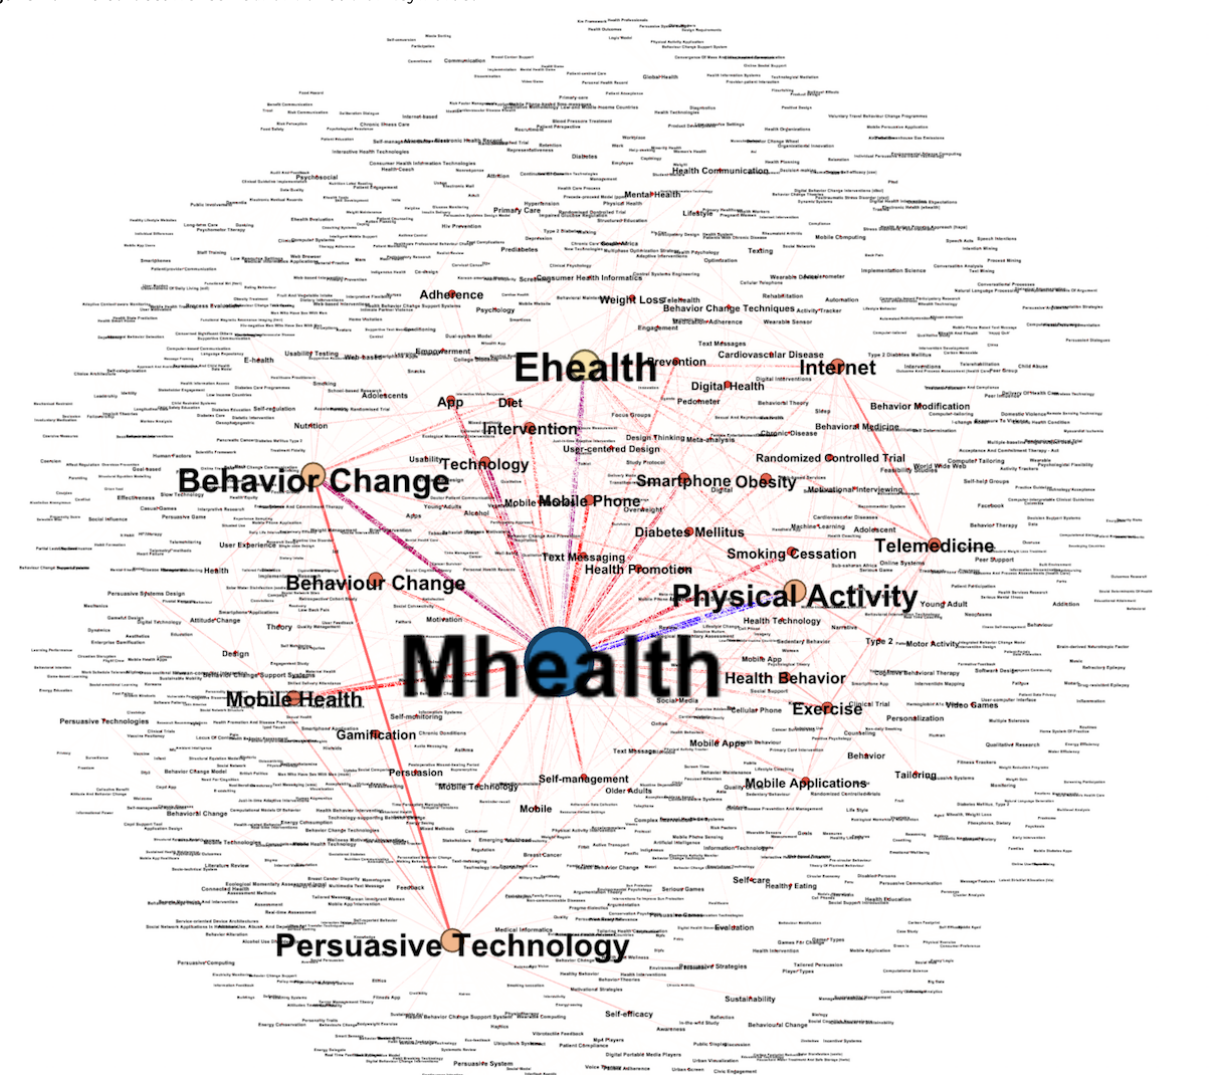
Figure 4. The co-occurrence network of author